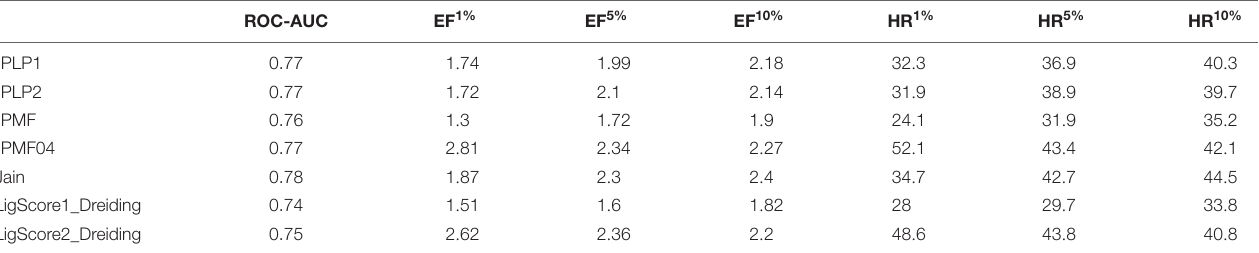
TABLE 3 | Area under the ROC curve, sensitivity, specificity, enrichment factors and hit rates at 1, 5, and 10% of ranked compounds after docking and scoring by seven different scoring functions. ROC-AUC EF 1% EF 5%